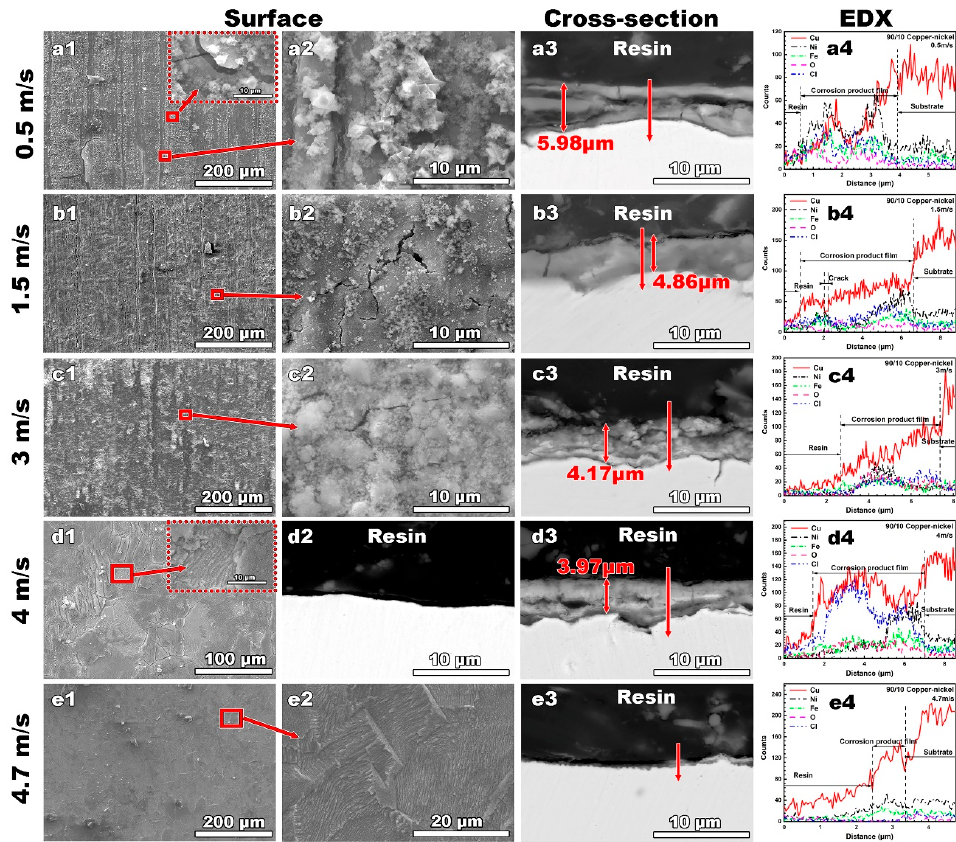
Figure 6. Surface and cross-section morphologies of the 90/10 copper–nickel samples after the 10-day erosion–corrosion test in 1 wt% NaCl solution at different flow velocities: ( a1 – a3 ) 0.5 m/s, ( b1 – b3 ) 1.5 m/s, ( c1 – c3 ) 3 m/s, ( d1 – d3 ) 4 m/s, and ( e1 – e3 ) 4.7 m/s; ( a4 – e4 ) the corresponding EDS profiles along the red lines marked in ( a3 – e3 ), respectively.